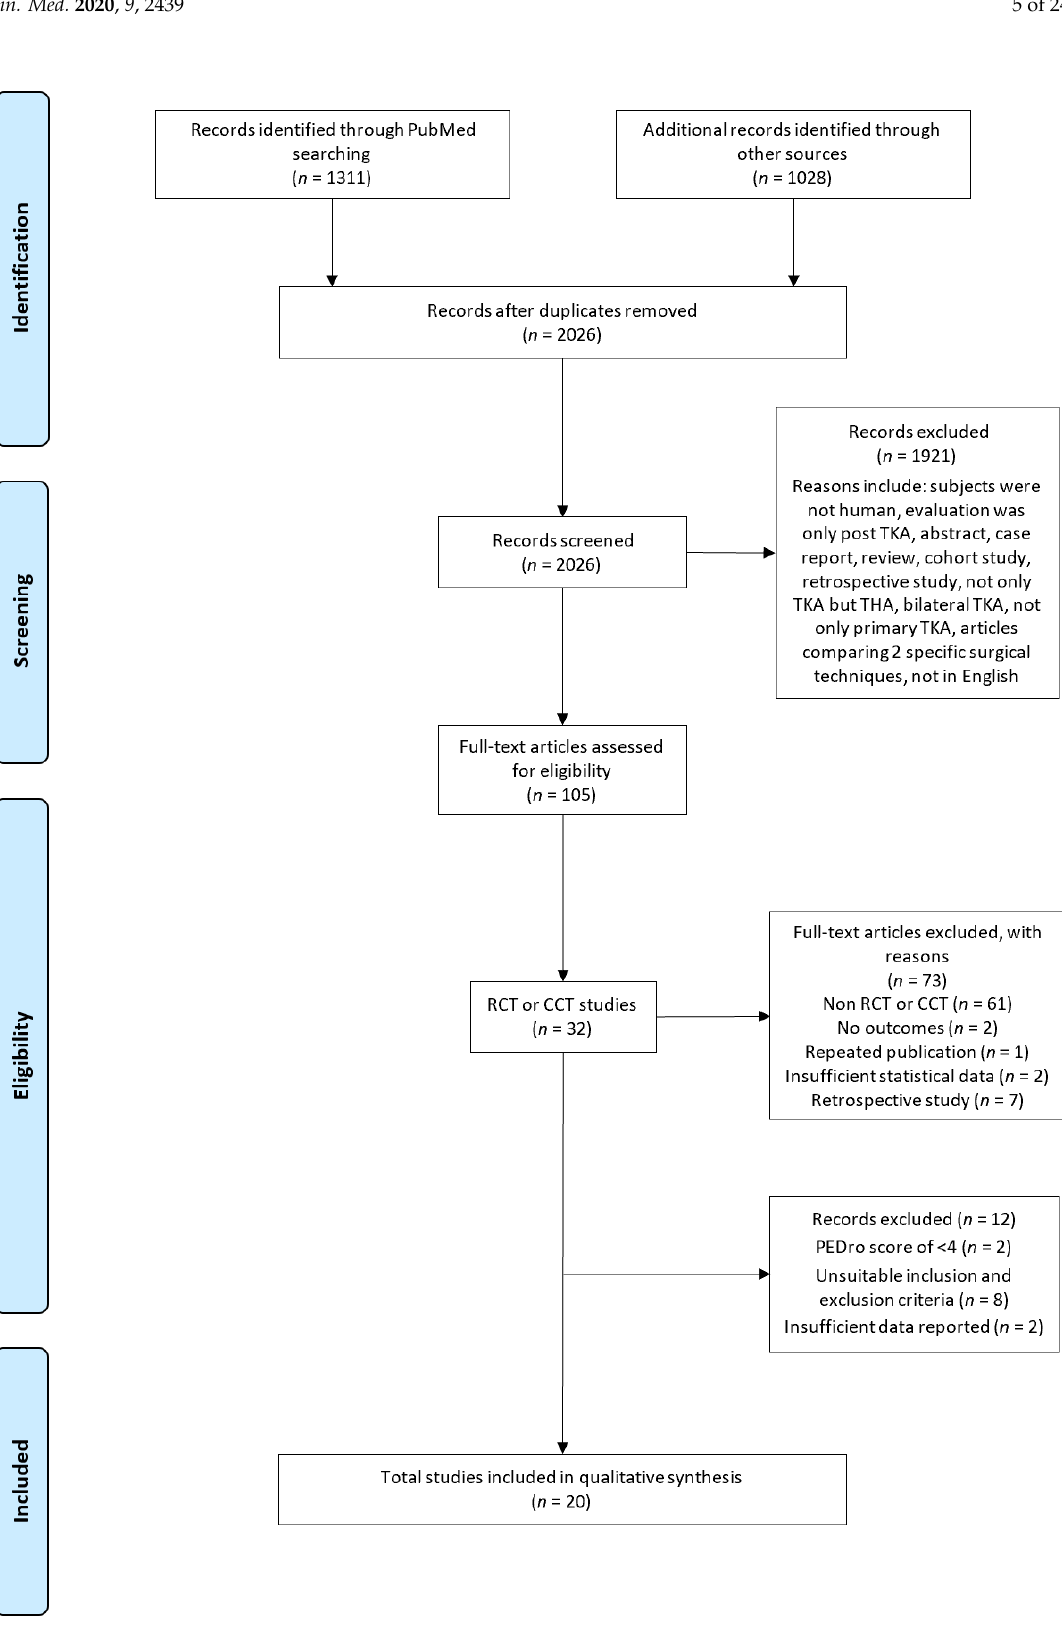
Figure 1. PRISMA flowchart diagram of the search process. RCT, randomized controlled trial; CCT, clinical controlled trial; TKA, total knee arthroplasty.